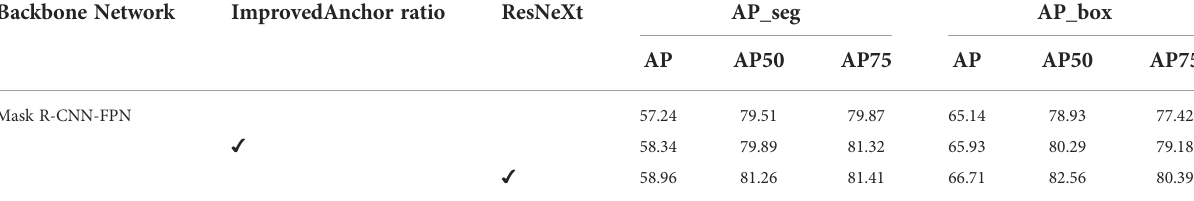
TABLE 2 The detect results of different Anchor and Backbone. Backbone Network